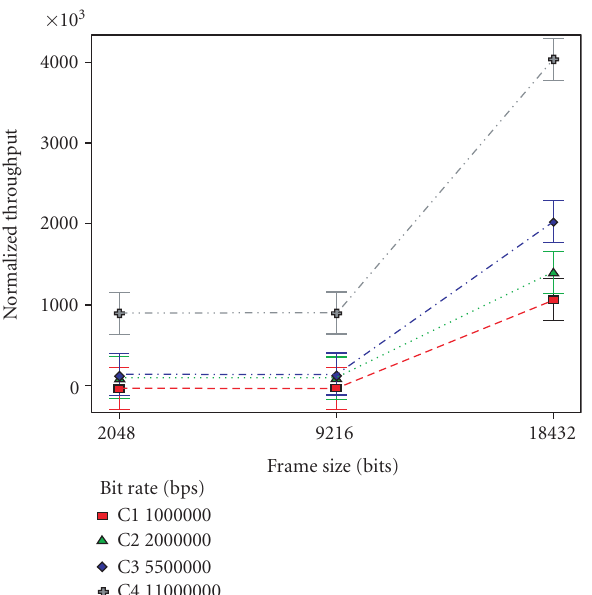
Figure 8: Analysis of frame size and data rate’s e ff ect on FTP throughput.